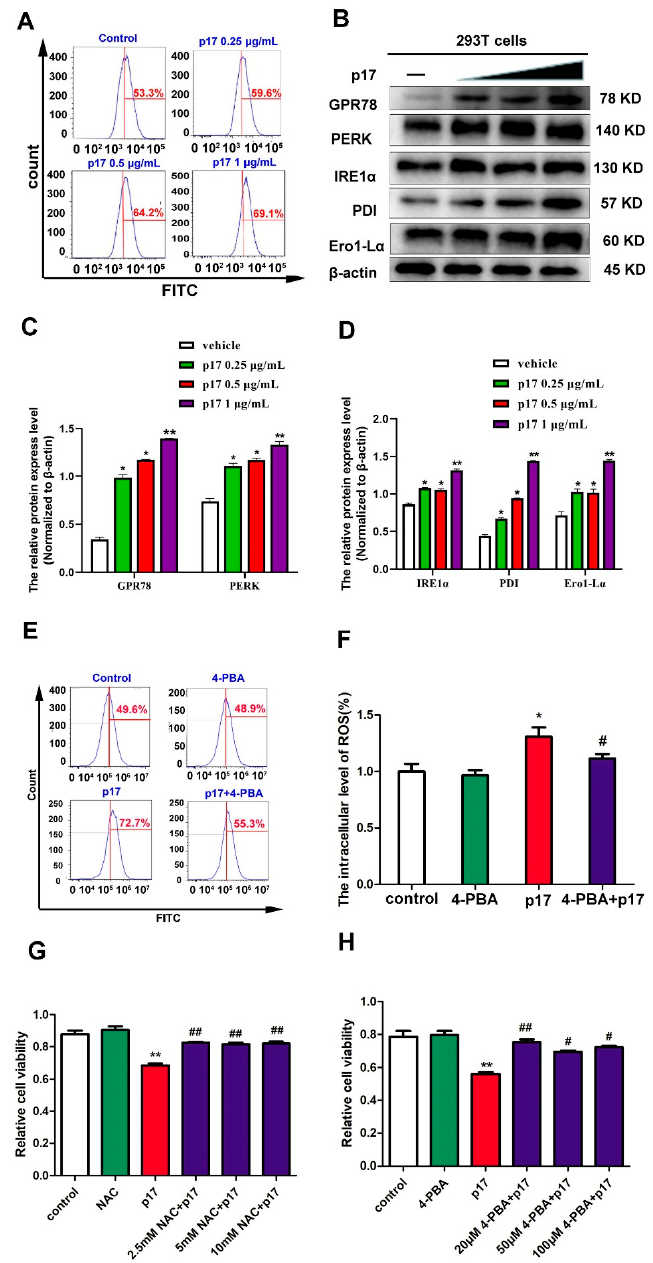
Figure 5. P17 could induce ER stress, and ER stress was responsible for the p17-inhibited cell proliferation. ( A ) The effect of p17 on the level of intracellular Ca 2+ was analyzed using Fluo-3 AM staining followed by flow cytometry. P17 groups were transfected with FLAG-p17 plasmids (0.25, 0.5, and 1 µ g/mL) for 24 h. ( B ) The effect of p17 on the expressions of GPR78, PERK, IRE1 α , PDI, and Ero1-L α . P17 groups were transfected with FLAG-p17 plasmids (0.25, 0.5, and 1 µ g/mL) for 24 h. ( C , D ) The intensity of the western blot bands was quantified by densitometric analysis. ( E , F ) 4-PBA pre-treatment could decrease the production of ROS by p17. 293T cells were pretreated with 4-PBA (20 µ M) for 30 min, and then transfected with p17 gene in the presence of 4-PBA for another 24 h. ( G ) The role of ROS in the decrease of cell proliferation induced by p17 was analyzed by using the CCK8 assay. Using NAC (2.5 mM) to alleviate the production of ROS could reverse the decrease of cell proliferation induced by p17 in 293T cells. 293T cells were pretreated with NAC for 30 min, and then transfected with P17 gene in the presence of 4-PBA for another 24 h. ( H ) The role of ER stress in the decrease of cell proliferation induced by p17 was analyzed by using the CCK8 assay. Using 4-PBA (20 µ M) to alleviate ER stress could also prevent the cell proliferation decrease induced by p17. Control groups were transfecting with empty plasmids. Values represent the mean ± SD; * p < 0.05, ** p < 0.01 versus control groups; # p < 0.05, ## p < 0.01 versus p17